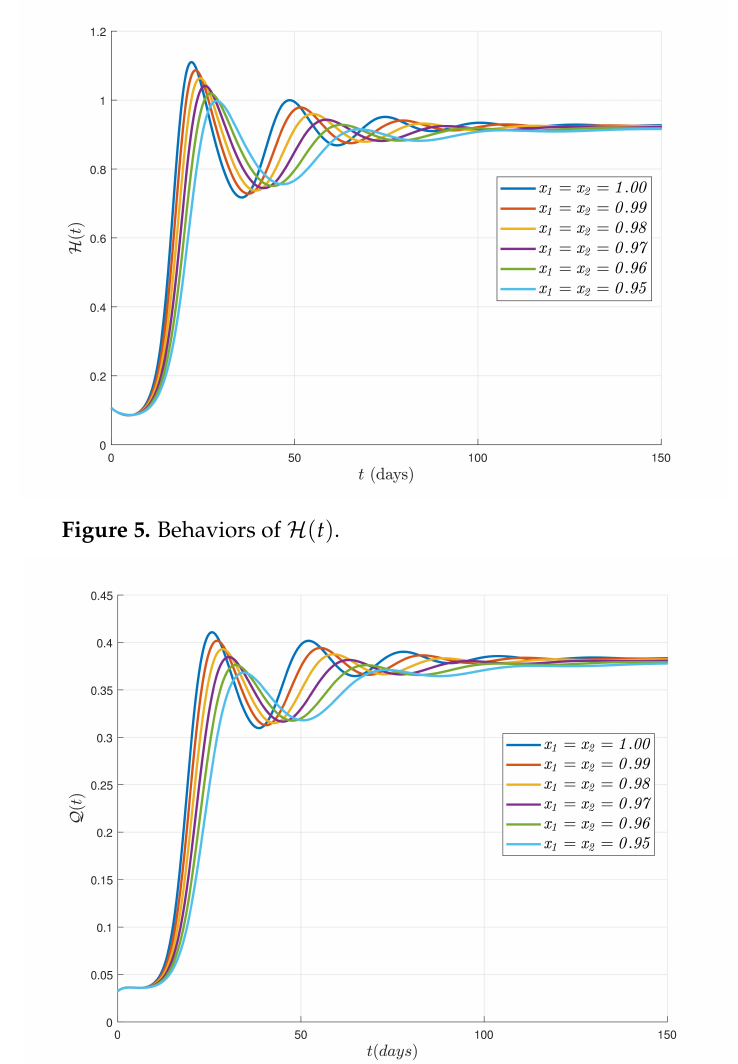
Figure 6. Behaviors of Q ( t )